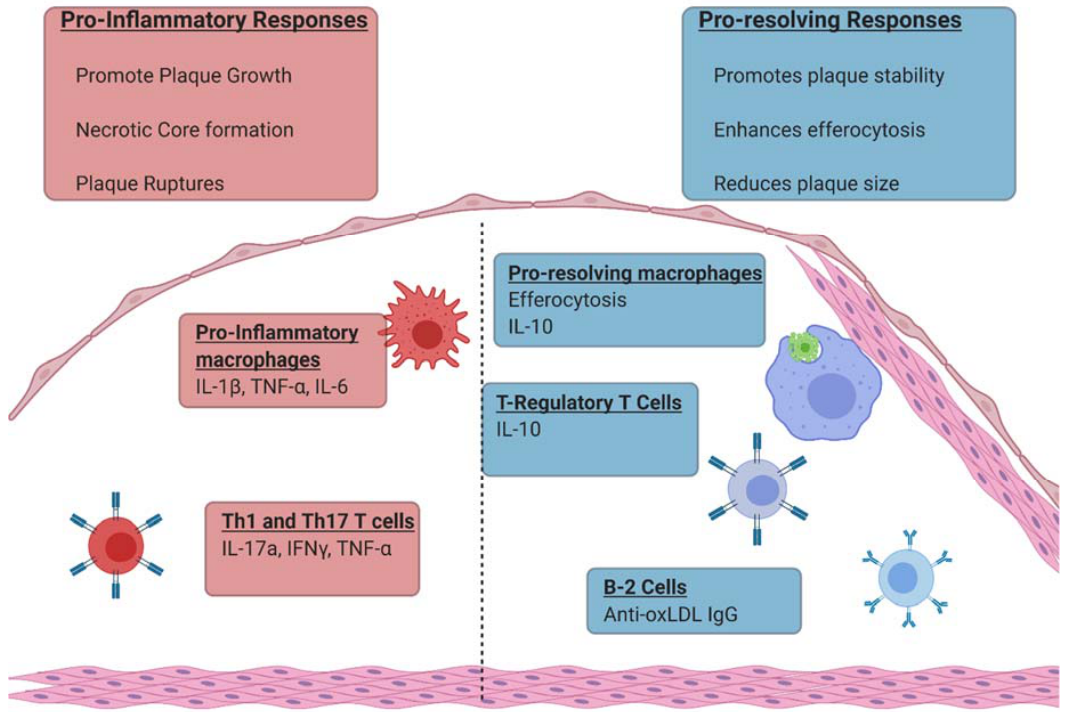
Figure 2. Immunological responses that contribute to plaque progression and plaque